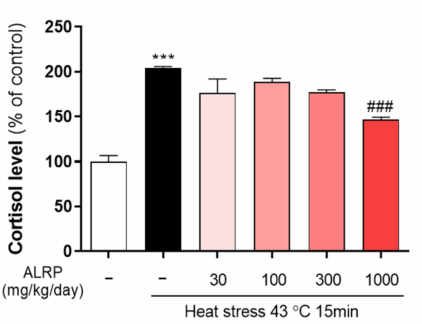
Figure 5. Suppressive effect of ALRP on heat exposure-induced increase of cortisol secretion (n = 6 per group). Values are expressed as means ± SEM. *** p < 0.001 as compared with the control group. ### p < 0.001 as compared with the heat-stressed vehicle-treated